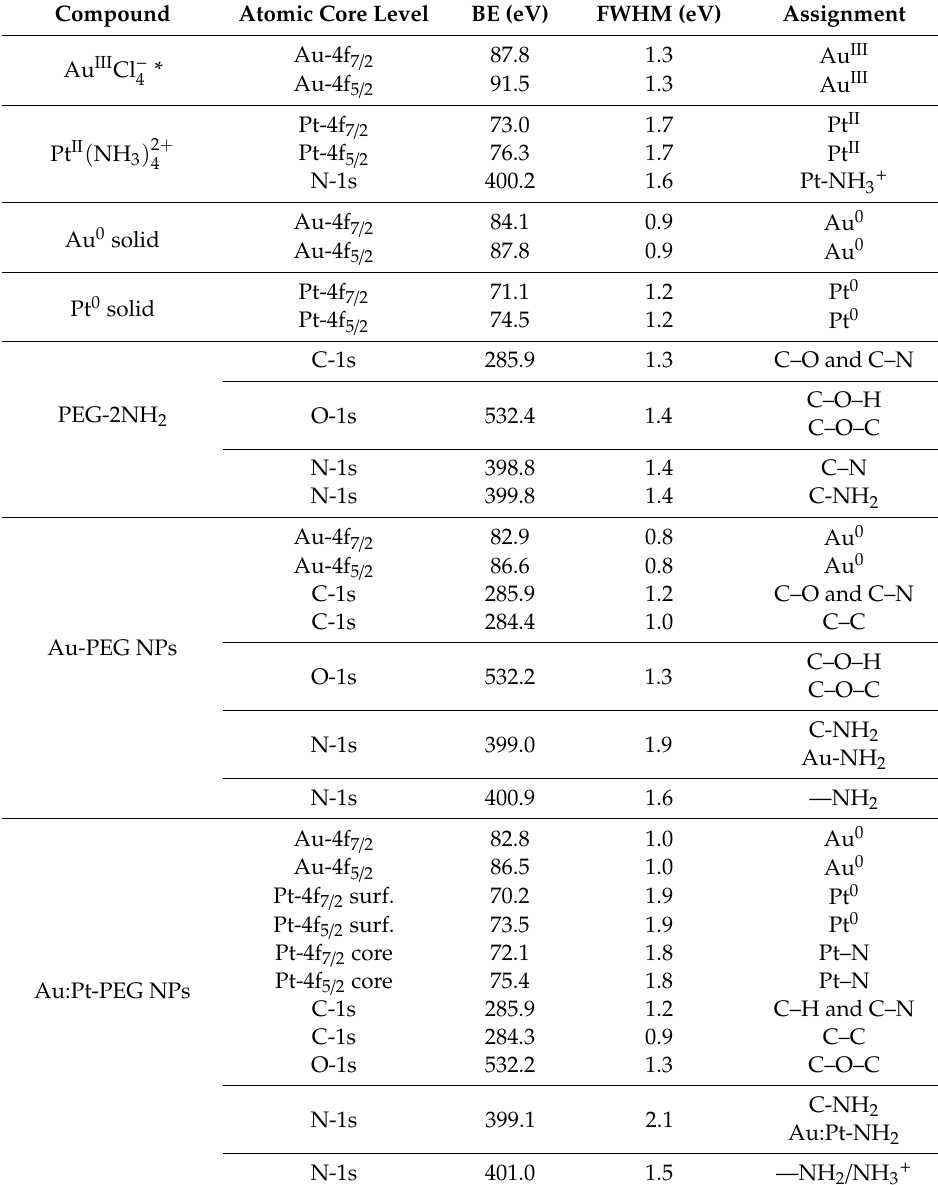
− , Pt II ( NH 3 ) 2 + , Au 0 solid, Pt 0 4 4